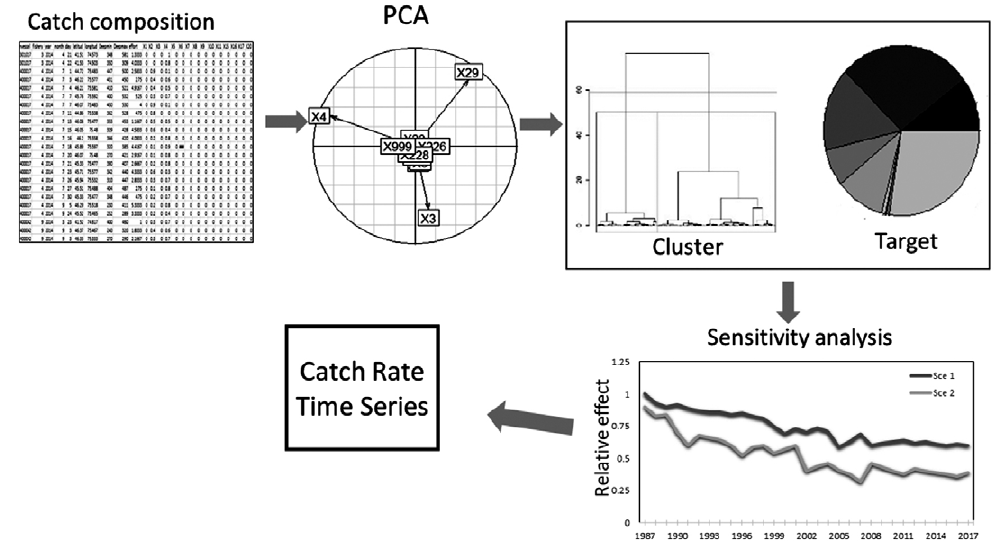
Fig. 3. – Schematic diagram of the statistical analysis implemented to assign catch intention in the longline fishery of pink cusk-eel.